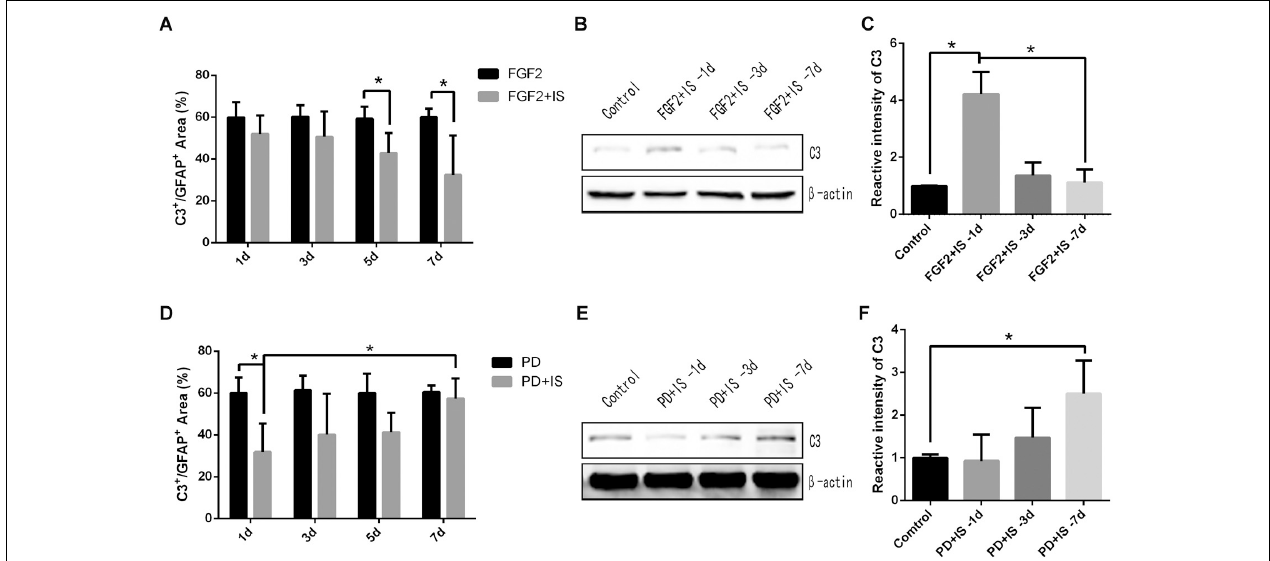
FIGURE 4 | A1 astrocytes were gradually down-regulated by activation of the FGF2/FGFR1 pathway and were up-regulated by inhibition of the FGF2/FGFR1 pathway. (A,D) Quantitative analysis of percentage of C3 + /GFAP + area in the CA1 region of rat hippocampus in different groups, by immunofluorescence staining. (B,E) C3 expression in rat hippocampus in different groups by western blotting. (C,F) Semi-quantitative analysis of C3 expression in rat hippocampus in different groups. N = 6–8 for each experiment. One-way ANOVA. Values expressed as mean ± SD. ∗ P <